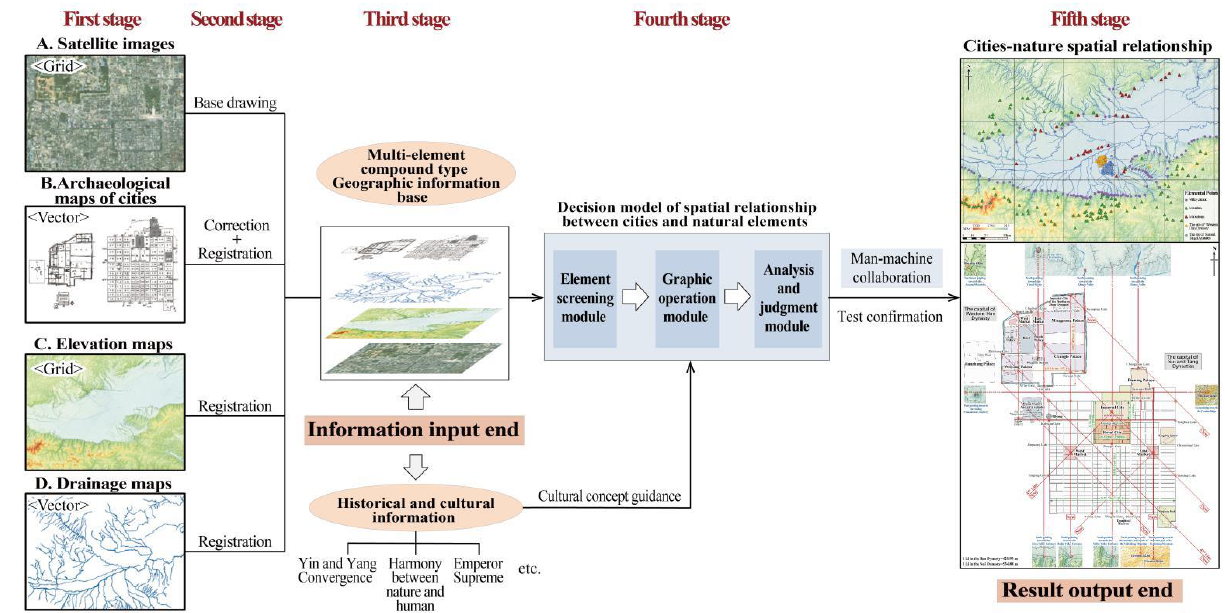
Figure 2. Technological roadmap for the research.